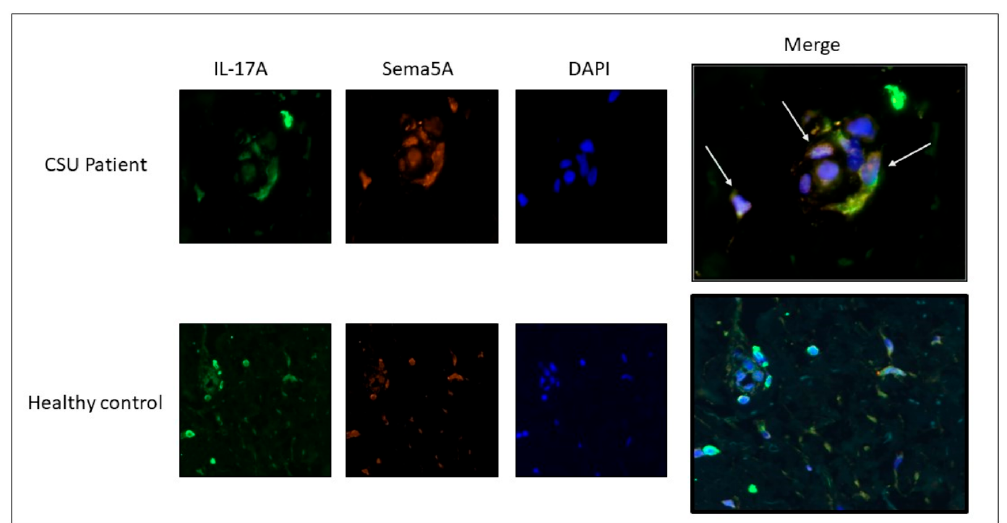
Figure 4. Increased co-expression of Sema5A/IL-17A in CSU skin biopsies. Co-expression of Sema5A and IL-17A was evaluated in skin biopsies taken from healthy subjects and CSU patients. Co-expression of Sema5A/IL-17A is significantly increased in skin biopsies of CSU patients (white arrows). The CSU patient pictures are 40X magnification, and the healthy control pictures are 20× magnification.